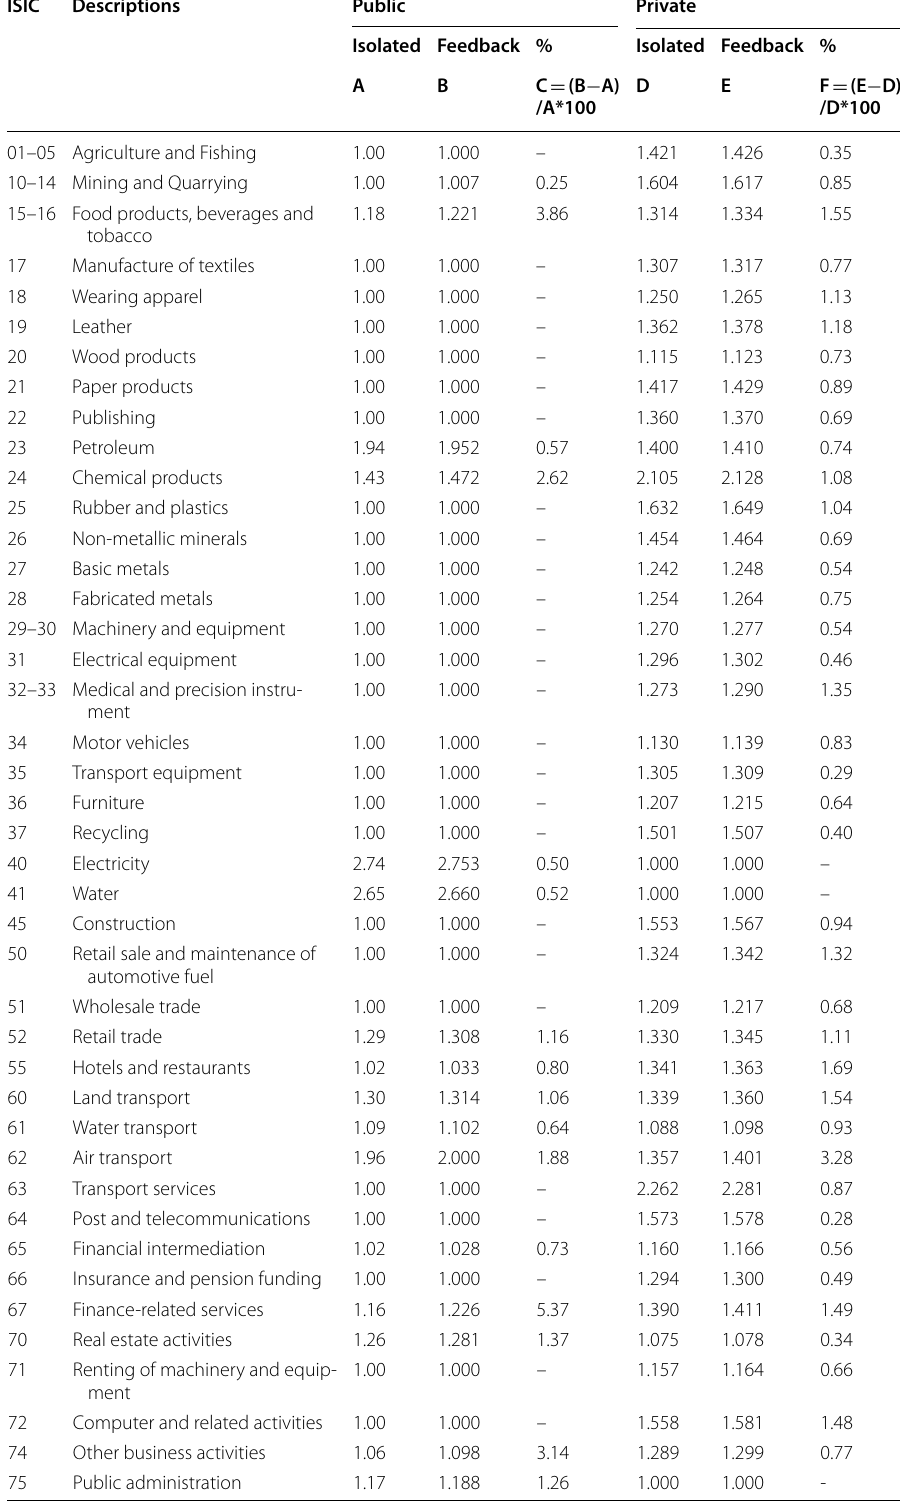
Table 6 Feedback effects in public and private sector multipliers. Source: computed by the authors based on CSB (2013)